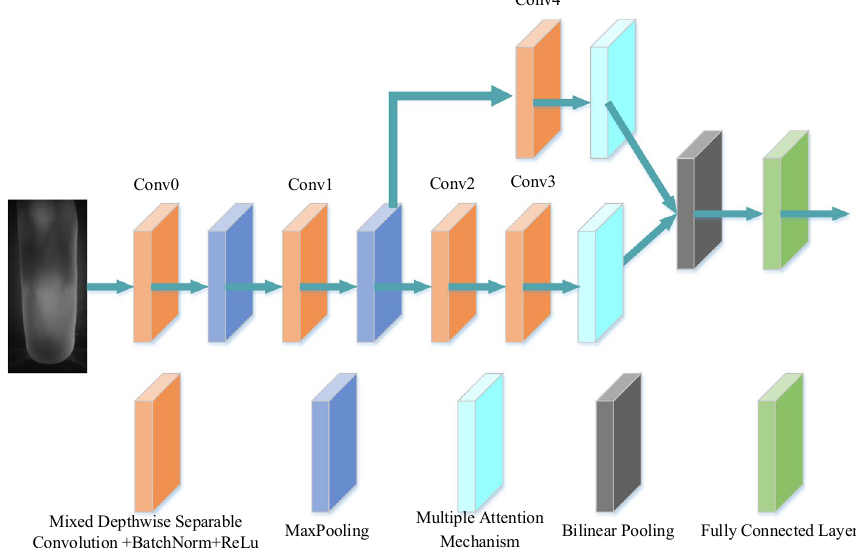
Figure 4. Proposed lightweight MSFBF-Net with attention